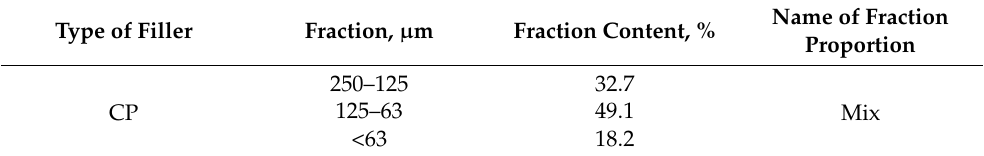
Table 1. Fraction proportions of milled CP filler